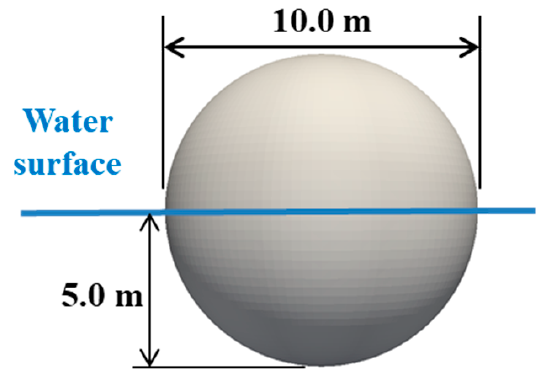
Figure 3. Model of a spherical float.